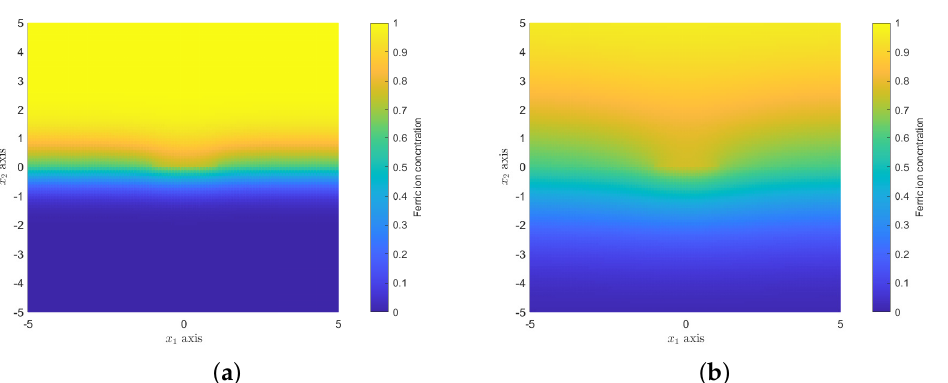
Figure 9. Non-dimensional concentration of ferric ions across two media c ( t , x 1 , x 2 ) : ( a ) at time t = 0.5; ( b ) at time t = 5.